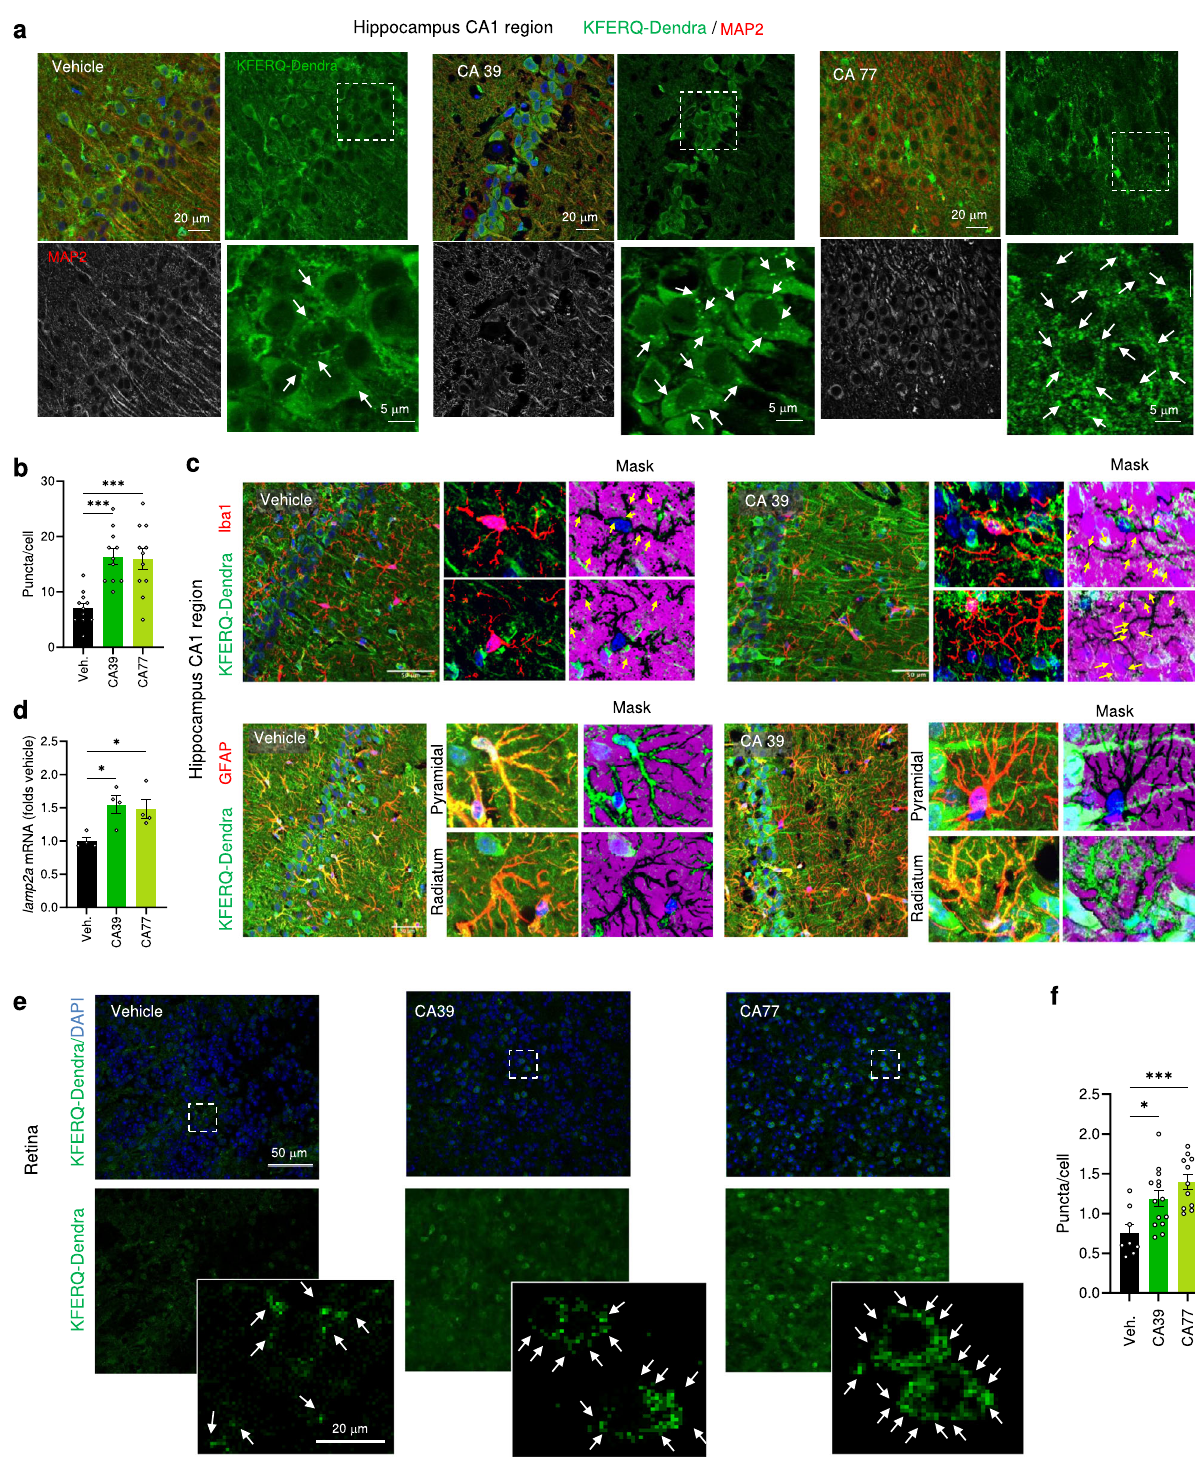
Fig. 4 CA compounds activate CMA in CNS and retina in vivo. a Representative images of the hippocampus (CA1 region) from KFERQ-Dendra mice i.p. injected with vehicle, CA39 or CA77 daily with (30 mg/kg bw) for three consecutive days co-stained with MAP2. Merged and individual channels are shown. Inset: higher magni fi cation of the boxed area. Arrows: Dendra + puncta. b Quanti fi cation of the number of Dendra + puncta per MAP2 + cell. n = 12 sections from 4 different mice. c Representative images of the hippocampus (CA1 region) from KFERQ-Dendra mice i.p. injected with vehicle or CA39 as in a co-stained with Iba1 (top) or GFAP/S100 (bottom). Merged channels are shown. Insets: higher magni fi cation to highlight individual cells (left) and inverted mask for the Iba1 (top) or GFAP (bottom) channel to better appreciate Dendra + puncta. d mRNA levels of lamp2a in the same brain regions as in a . n = 4 mice per condition. e Representative images of fl at-mounted retinas from KFERQ-Dendra mice treated as in c . Nuclei are highlighted with DAPI on the top. Insets: higher magni fi cation images. Arrows: Dendra + puncta. f Quanti fi cation of the number of Dendra + puncta per cell. n = 14 fi elds from 3 independent experiments. All values are mean + s.e.m. One-way ANOVA followed by Bonferroni ’ s multiple comparisons posthoc test was used in b , d , f . * p < 0.05 and *** p < 0.001. Source data and exact p values are provided as a Source Data fi